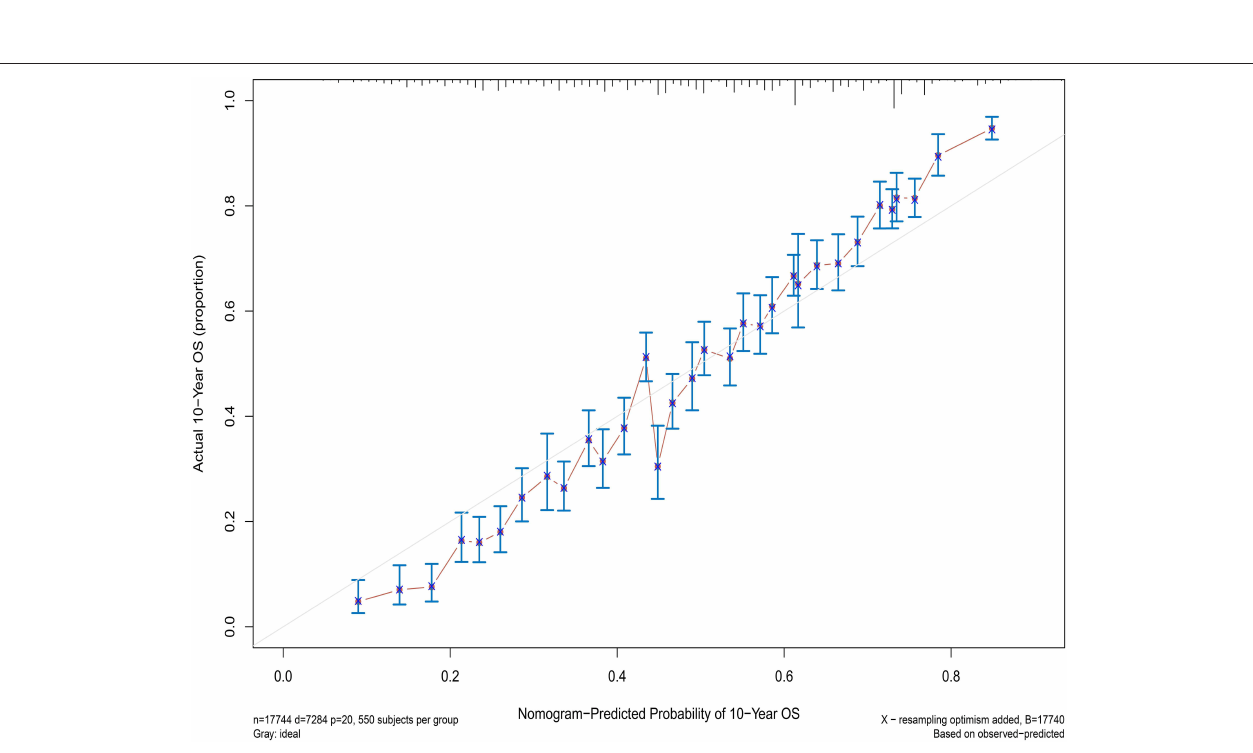
FIGURE 11 | The calibration curves for predictions of overall survival at 10 years after diagnosis.